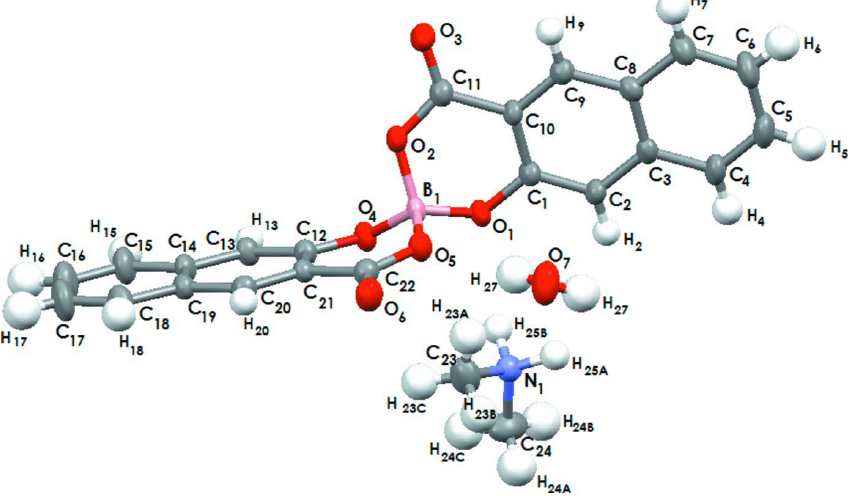
Showing the atom-labelling scheme of (I). Displacement ellipsoids are drawn at the 50% probability